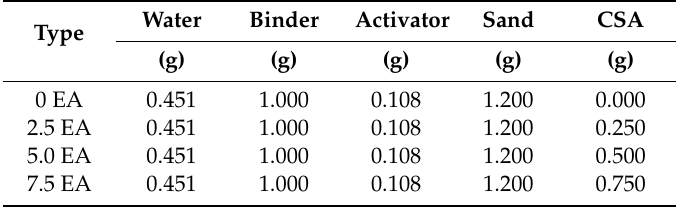
Table 2. Mix proportions of alkali-activated material (AAM)